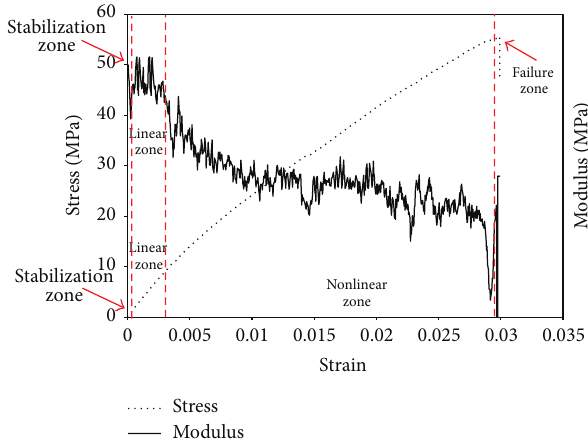
Figure 2: Young’s modulus (continuous line) and flexural strength (dotted line) in function of deformation for a HA-20 reference composite sample.